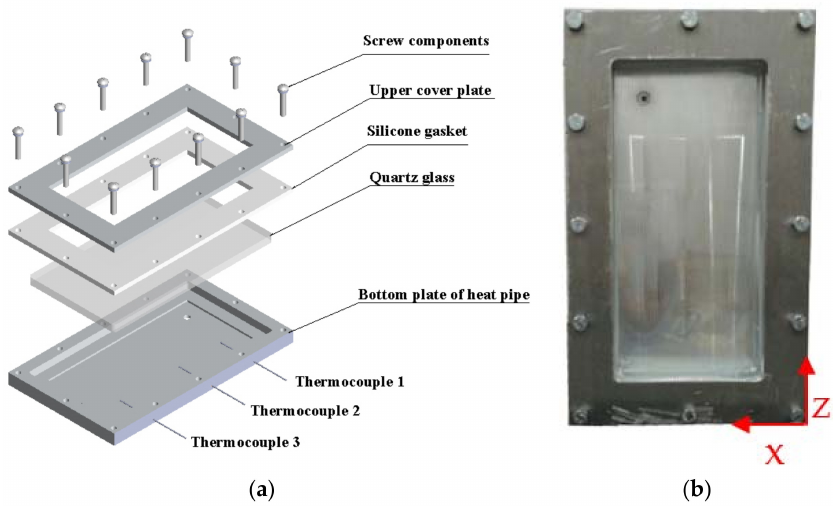
Figure 2. Dismantled parts ( a ) and assembly ( b ) diagrams of the